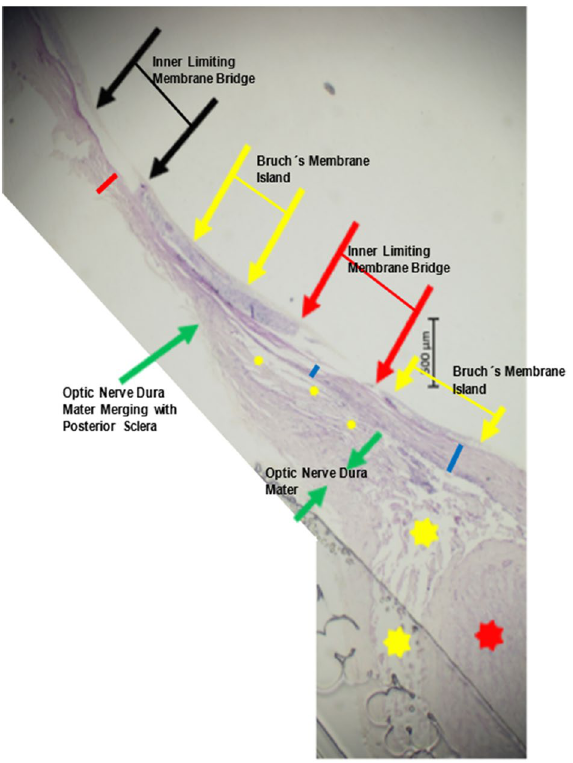
Figure 1. Histo-photograph showing the retina of an extremely elongated eye (axial length: 30.0 mm) with two regions (“inner limiting membrane (ILM) bridge”) (between both black arrows (length: 0.62 mm) and between both red arrows (length: 0.73 mm)) in which the retina consisted only of the inner limiting membrane; long green arrow; merging point of optic nerve dura mater (between both short green arrows) with the posterior sclera; two blue bars: peripapillary scleral flange (thickness: 230 µm and 80 µm), ending at the merging point of the optic nerve dura mater with the posterior sclera; yellow (small and large) asterisks: orbital cerebrospinal fluid space; red asterisks: optic nerve; red bar: scleral thickness of 173 µm; distance between the right ILM-bridge and the optic disc border: 1.92 mm; distance between both ILM-bridges: 1.56 mm; length of ILM-bridges: 0.73 mm (right ILM-bridge) and 0.62 mm (left ILM-bridge).